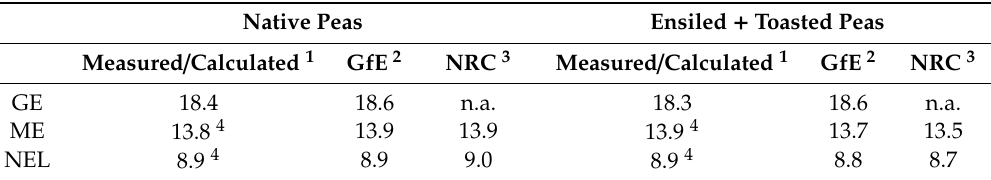
Table 6. Gross energy (GE), metabolizable energy (ME), and net energy lactation (NEL) in native and ensiled + toasted field pea